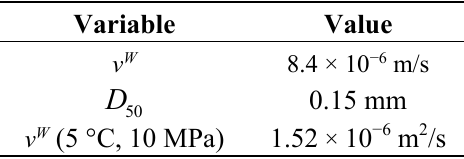
Table 4. Substituting those values into the Reynolds number equations, we obtain Re . ~    for the water flow. 10 water Table 4. Parameters for calculating Reynolds number of water flow.